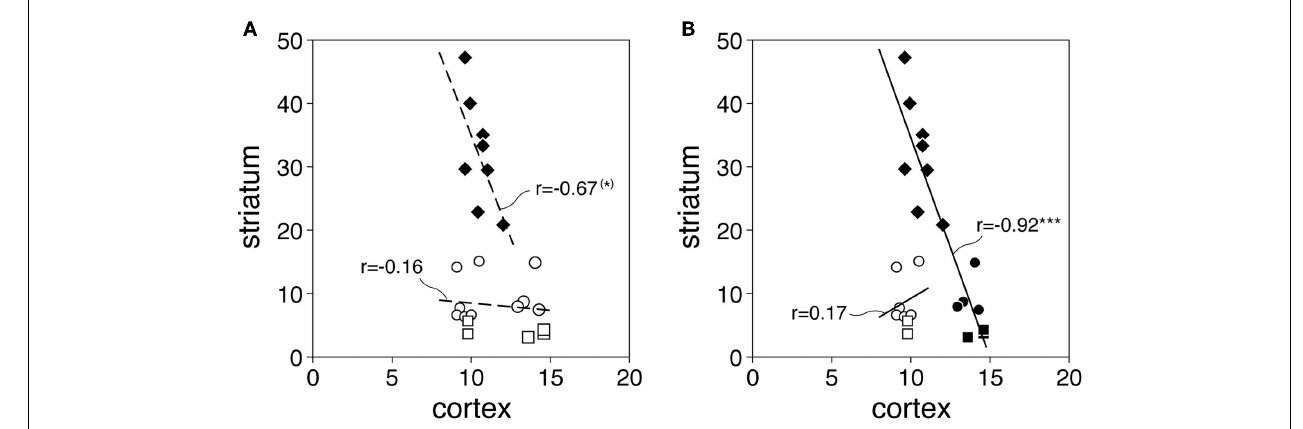
(circles), and 5 limbic/NAc circuits (squares) are displayed. Results (B) show a negative correlation between cortical and striatal CB1 expression for pooled sensorimotor circuits plus associative/limbic/NAc circuits with inputs from medial prefrontal cortex (IL, PL, CG; see Figure 2 ) (filled symbols, n = 15; r =− 0.92, *** P < 0.0001). ( * ) P =